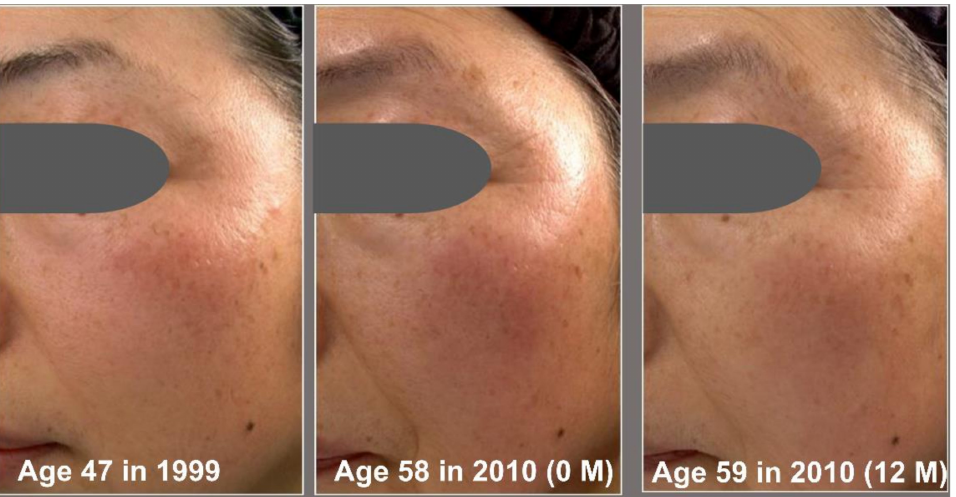
Figure 6. Chronological facial images of Case 1 (age: 47 in 1999). Twice-daily application of G3 products was performed from 2010 (0 M) to 2010 (12 M). The visual facial appearance aged from 1999 to 2010 (0 M), but it was rejuvenated in 2010 (12 M) to close to the level in